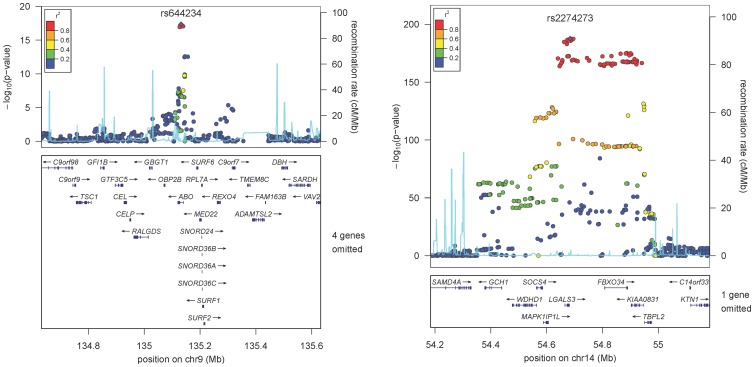
Regional plots at the two significantly associated loci.Horizontal axis indicates chromosomal location and P-values are indicated in the left y-axis. Each plot shows approximately ± 500 kb around each lead SNP and has known gene transcripts annotated at the bottom. The SNPs are colored according to their degree of linkage disequilibrium (r
2) with the lead SNP which is highlighted with a purple diamond and displayed by rs number and significance level achieved in the discovery analysis.